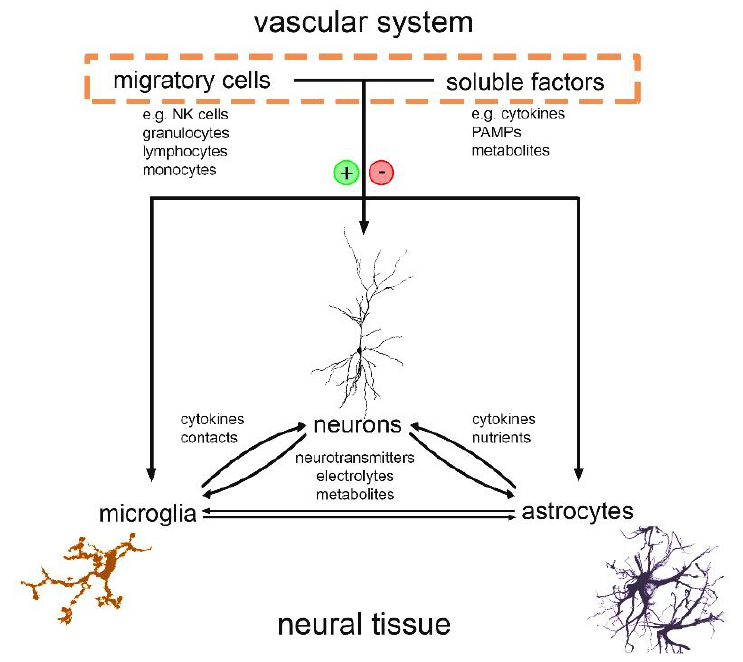
Figure 1. Blood–brain communication is a crucial regulatory element in neural circuit function. Neurons and glial cells bilaterally influence their function through various mediators, such as neurotransmitters, metabolites and brain derived cytokines. Moreover, soluble and cellular blood components can enter the central nervous system, when the permeability of the blood–brain interface changes. This intruiging blood–brain interaction can influence distinct features of neural circuits, e.g., network activity and the expression of synaptic plasticity.